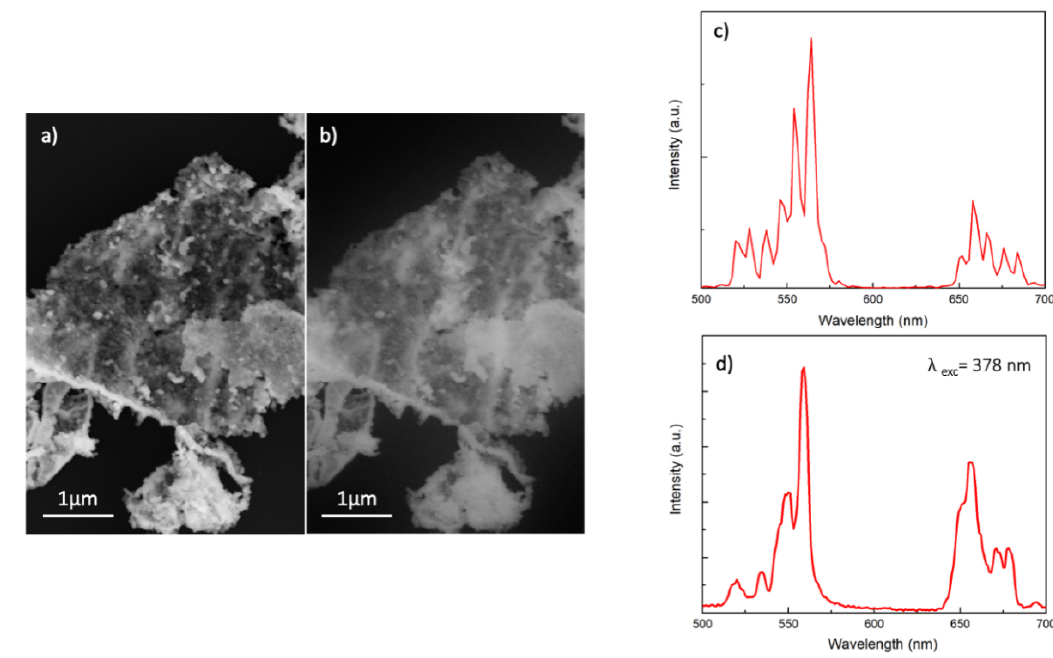
Figure 8. SEM image of Er:Y 2 O 3 NPs obtained by ( a ) secondary electrons and ( b ) cathodolumines- cence. Related emission spectra obtained by ( c ) electron beam excitation and ( d ) photoexcitation ( λ exc = 378 nm).